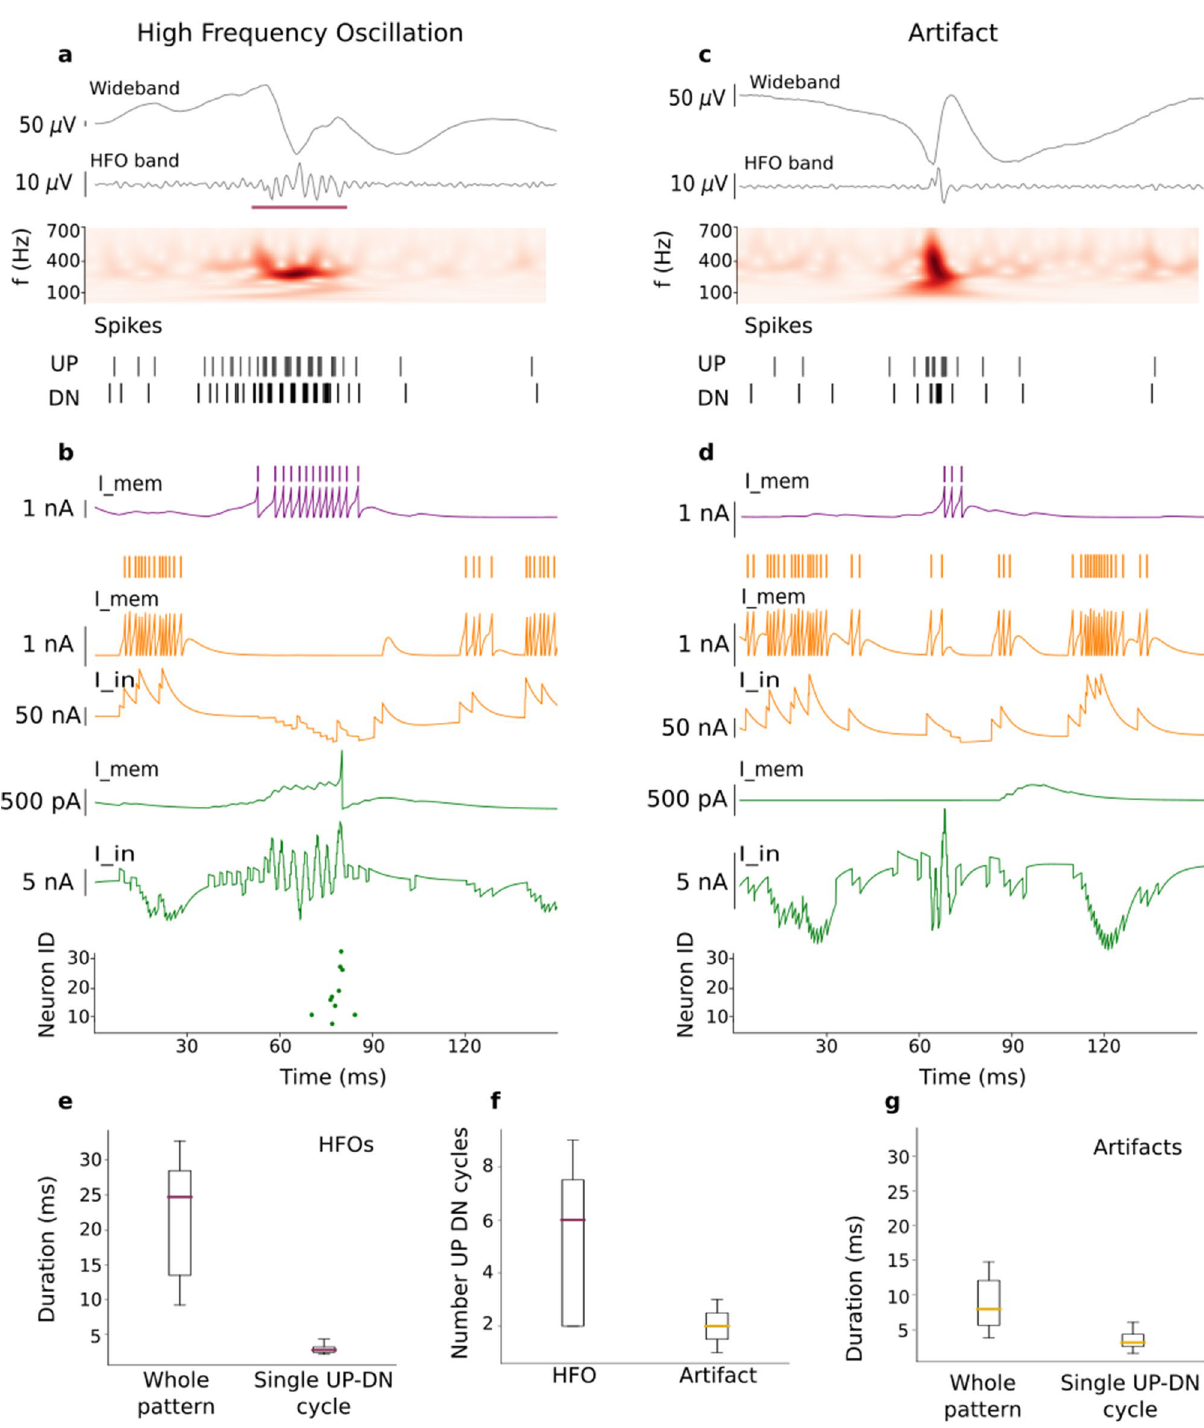
Figure 2. The SNN distinguishes between an HFO and an artifact (fast transient) in the ECoG. (a,c) ECoG signal and input spike train to the SNN. Consecutive UP-DN spike bursts in the train define an UP-DN cycle. More cycles occurred during the HFO. (b,d) Activity I mem of the neurons in the SNN. (b) During an HFO, the input spike train excited the dis-inhibitory neuron (membrane potential in I in I mem purple), which suppressed the global-inhibitory neuron that became silent (input current and in orange). A neuron of the core I in I mem SNN (input current and membrane potential in green) integrated the input spike trains and produced an output spike. Several second layer neurons of the core SNN responded to the HFO (green dots). (d) During a short fast transient in the ECoG, the excitation of the dis-inhibitory neuron was so short (purple trace) that it did not silence the global-inhibitory neuron (orange traces), which in turn continued to inhibit the second layer neuron (green traces) and prevented the generation of an output spike. Neither this nor any I mem other neuron of the second layer (green) reached the spiking threshold hence, the raster plot remained empty. (e,f,g) Population characteristics of the UP-DN input spike trains entering the second layer neurons and the dis-inhibitory neuron. (e) The train during an HFO lasted 24 ms (median), with a single cycle lasting 2.6 ms (median). (f) The HFOs comprise more UP-DN cycles (median 6 cycles) than the artifacts (median 2 cycles). (g) The train during an artifact lasted 9 ms (median), with a single cycle lasting 3.2 ms (median). The cycle characteristics were used to select the parameters of the dis-inhibitory neuron and the global-inhibitory neuron (Table